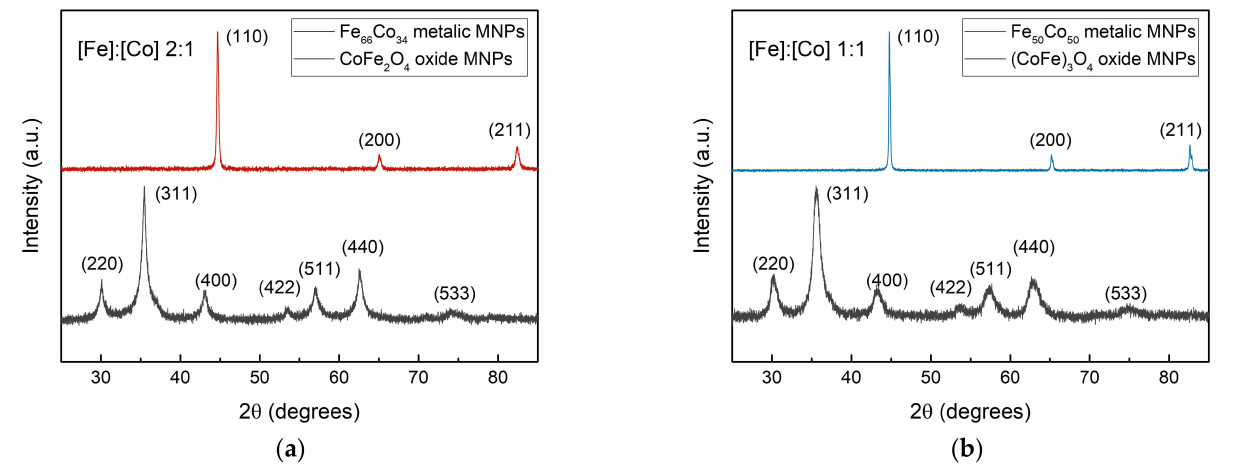
Figure 1. XRD patterns of ( a ) CoFe 2 O 4 and corresponding metallic Fe 66 Co 34 MNPs and ( b ) (CoFe) 3 O 4 and corresponding metallic Fe 50 Co 50 MNPs. Diffraction peaks of oxide and reduced powders are indexed by cubic spinel ferrite and body-centered cubic (bcc) FeCo phase, respectively (the corresponding Miller indexes are